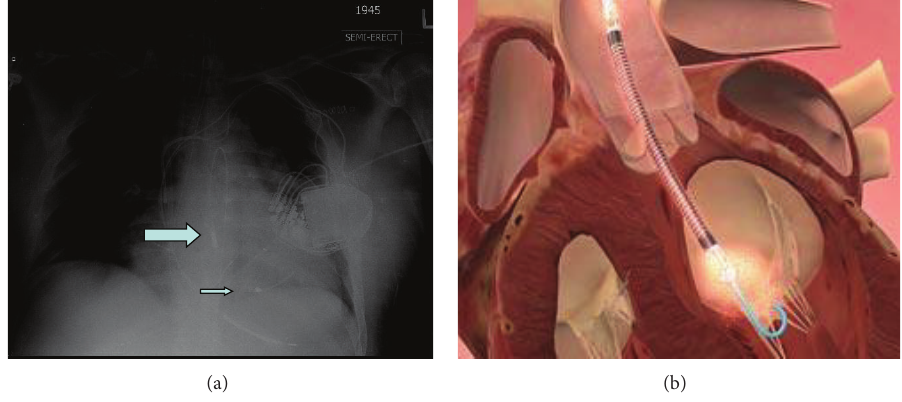
Figure 1: (a) An anteroposterior view of the chest showing the Impella inlet (marked with arrow) and outlet (marked with small arrow) below the aortic valve level. (b) Correct placement of Impella with supravalvular outlet (Courtesy of ABIOMED).